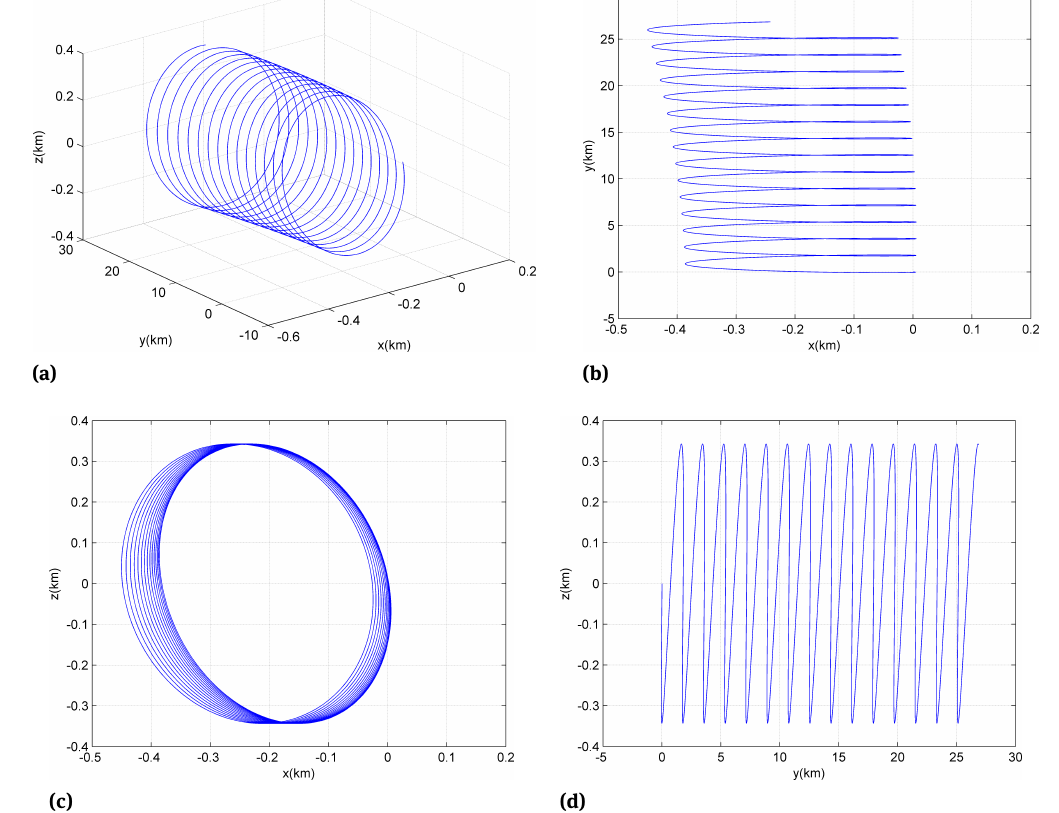
Figure 5. The relative position of object C relative to object A in the coordinate frame A-xyz . (a) 3D view; (b) xy plane; (c) xz plane; (d) yz plane.